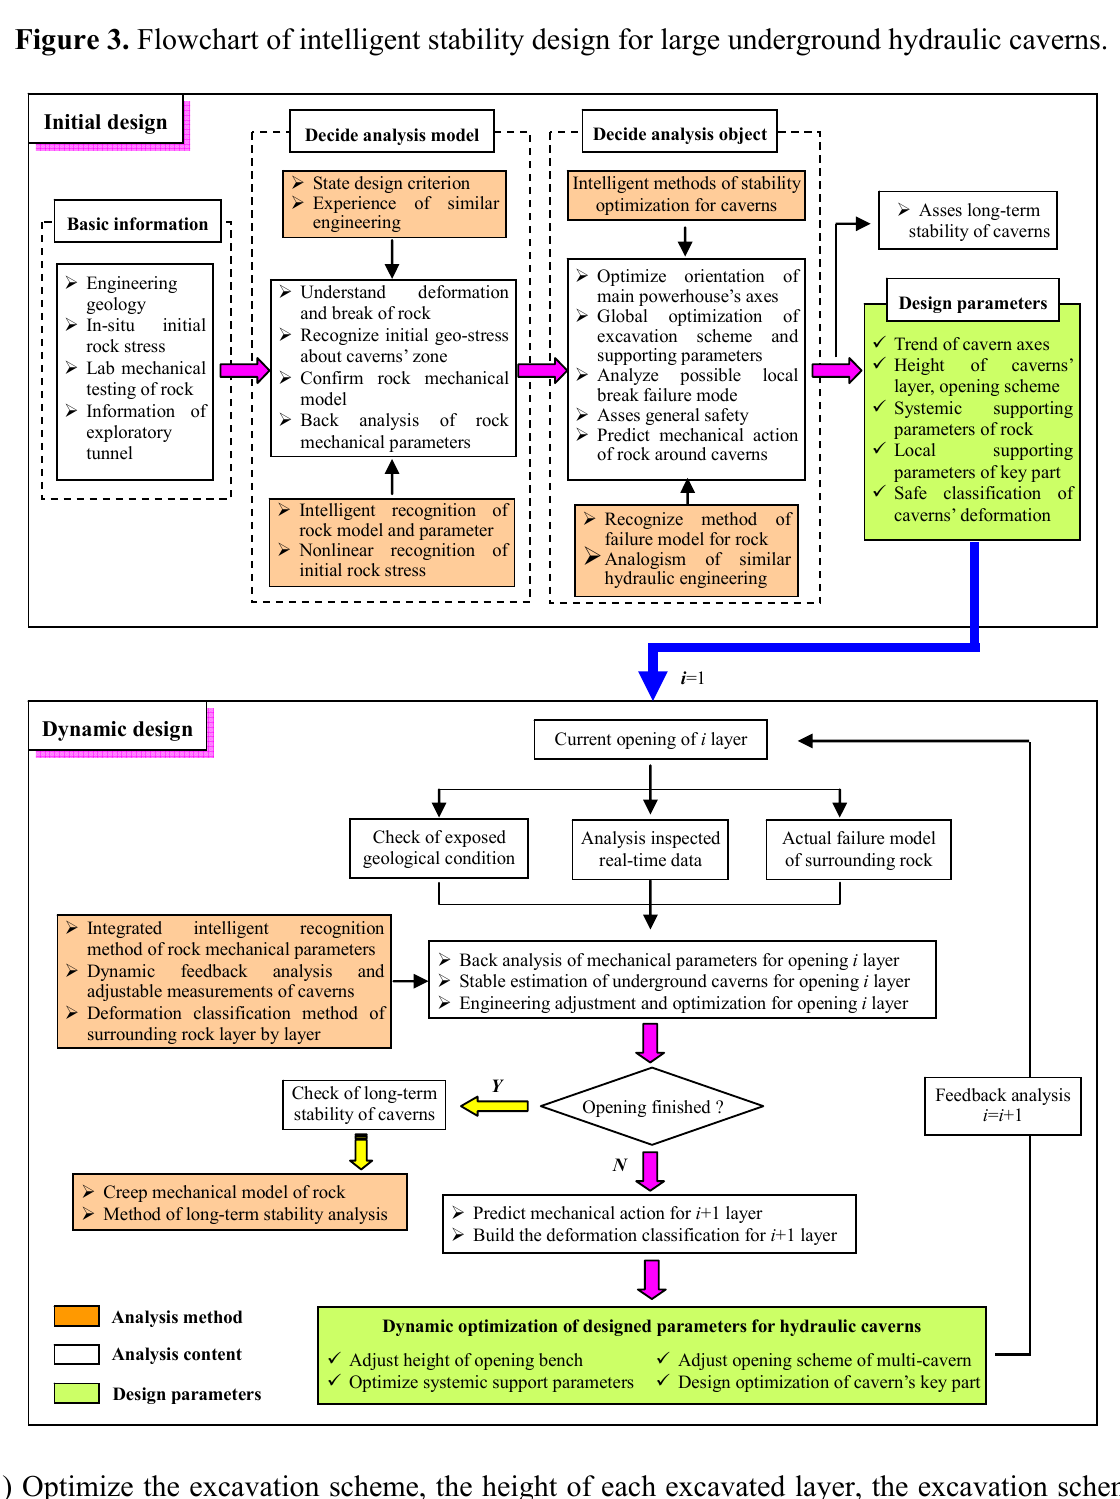
Figure 3. Flowchart of intelligent stability design for large underground hydraulic